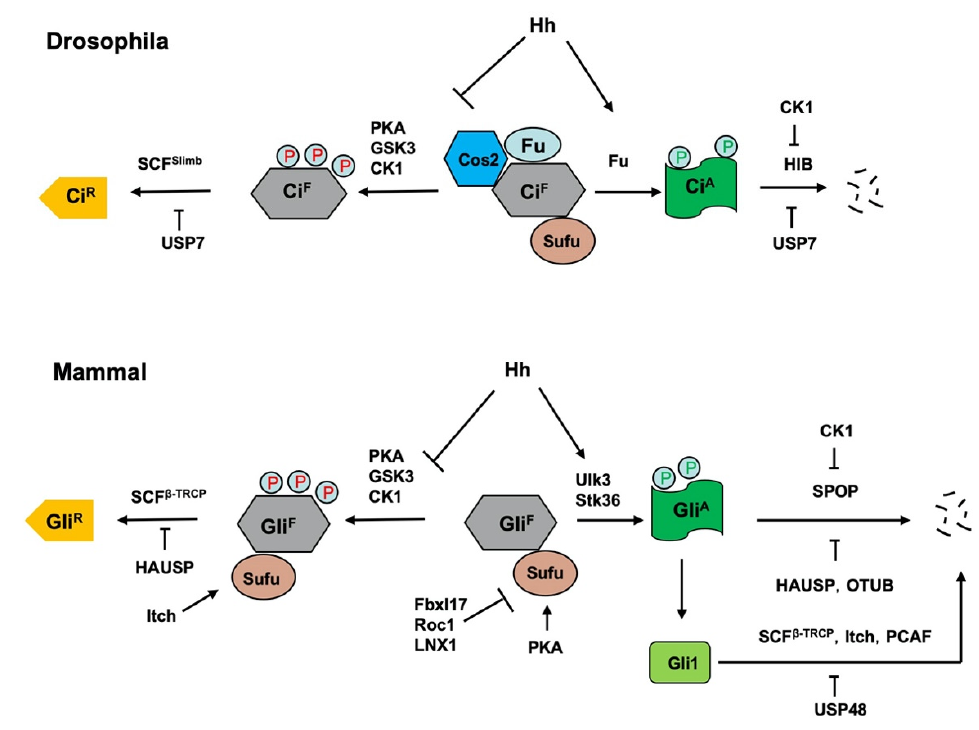
Figure 4. Regulation of Ci/Gli processing and degradation by E3s and DUBs. Hh signaling controls the balance between the repressor and activator forms of the Ci/Gli, which is regulated by the ubiquitin and proteasome system (UPS). In the absence of Hh, full-length Ci/Gli (mainly Gli3) is proteolytically processed to form truncated repressor (Ci R /Gli R ) through PKA/GSK3/CK1-mediated phosphorylation, followed by SCF Slimb /SCF β -TRCP -mediated ubiquitination. The DUB USP7/HAUSP antagonizes this process through deubiquitinating Ci/Gli. The E3 ligase Itch promotes Gli R production by ubiquitinating Sufu to increase its interaction with Gli3. Hh signaling blocks the proteolysis of Ci/Gli and converts accu- mulated full-length Ci/Gli into activator form Ci A /Gli A though phosphorylation by the Fu family kinases. When dissoci- ated from Sufu, Ci A /Gli A becomes labile and is degraded by HIB/SPOP, a process that is attenuated by CK1-meidated phosphorylation of Ci/Gli. The DUBs USP7/HAUSP and OTUB deubiquitinate Ci/Gli to inhibit its degradation. The E3 ligases SCF β -TRCP , Itch and PCAF promote Gli1 degradation while the DUB USP48 antagonizes this process. In addition, mammalian Sufu is degraded by multiple E3 ligases including Fbxl17, ROC1 and LNX1.